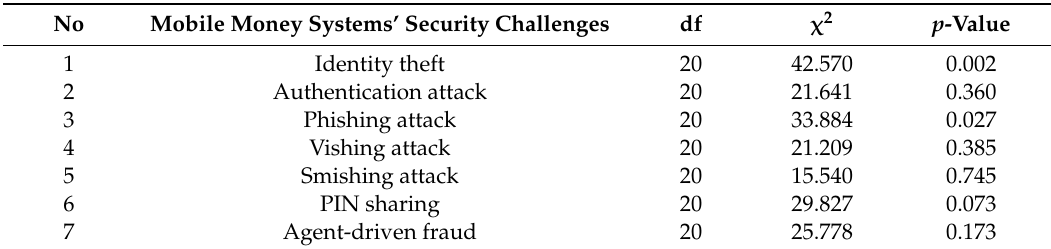
Table 9. Relationship between number of mobile money transactions in a month and mobile money systems’ security